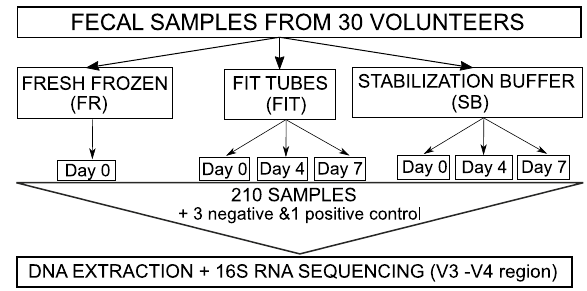
Figure 1. Workflow for sample collection and